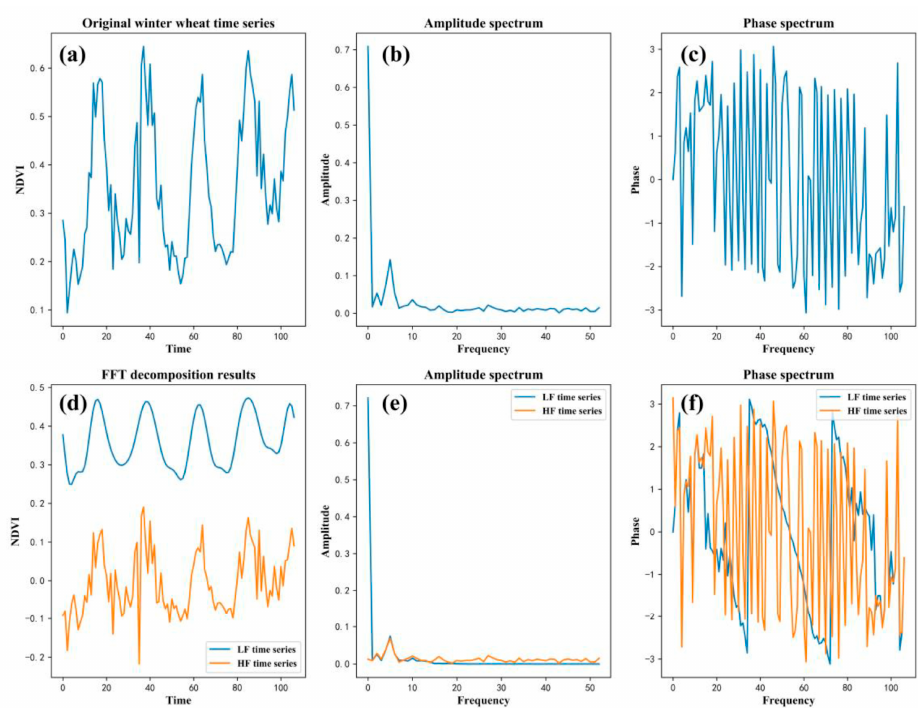
Figure 6. FFT decomposition of winter wheat NDVI time series. ( a ) Original winter wheat time series. ( b ) Amplitude spectrum. ( c ) Phase spectrum. ( d ) FFT decomposition results. ( e ) Amplitude spectrum of low-frequency (LF) time series and high-frequency (HF) time series. ( f ) Phase spectrum of LF time series and HF time series.